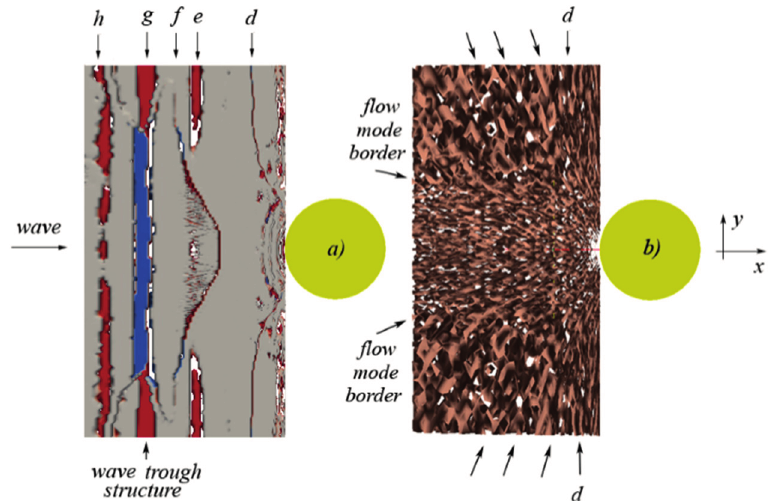
Figure 25. Flow-field representation at 0.144 T = ( T is wave period), top view (free-surface level): ( a ) flow-structures (colored with spanwise vorticity); ( b ) surfaces of constant x- velocity from reconstruction based on the three most energetic KL